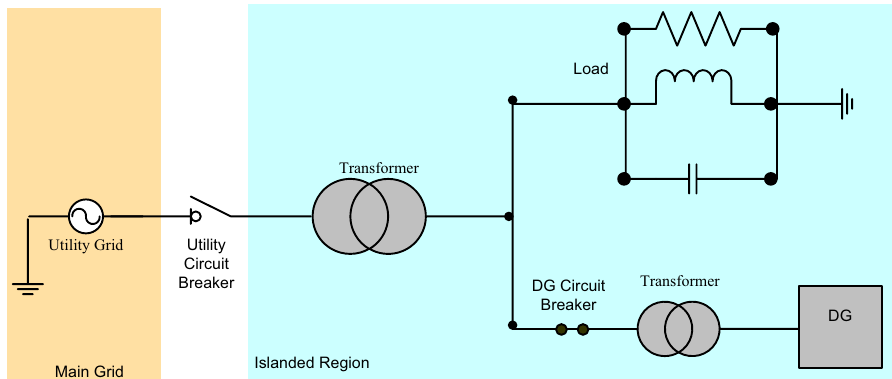
Fig. 1 Concept of islanding condition in power